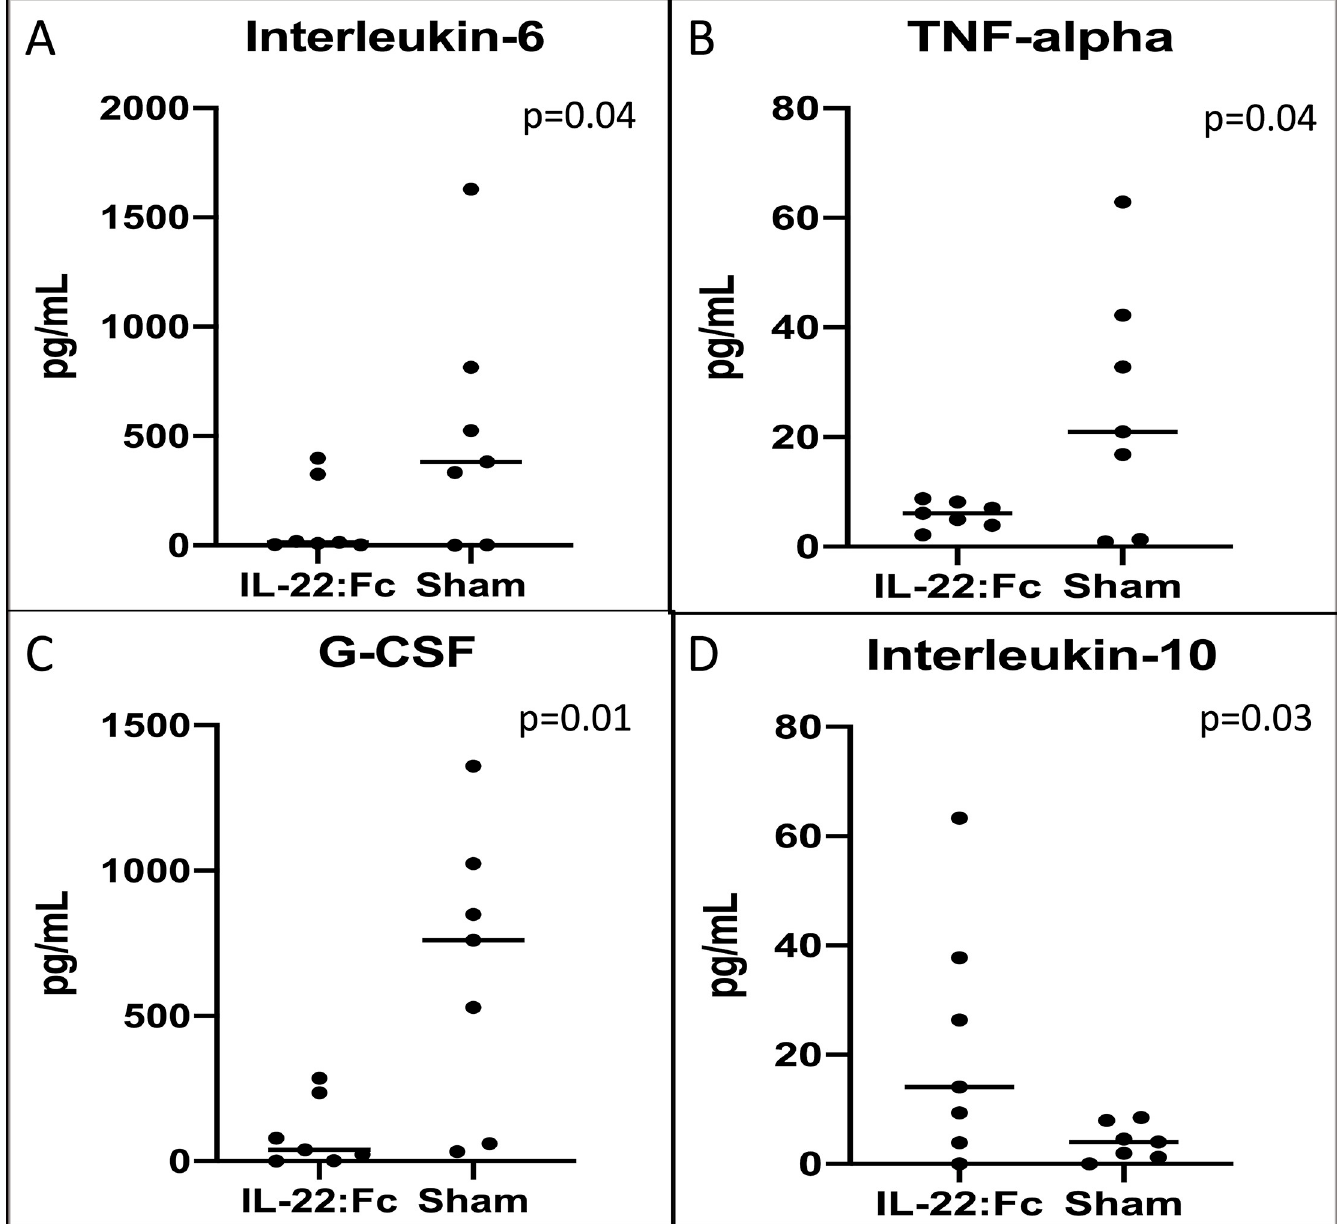
Fig 3. Measures of inflammatory mediators after high-dose LPS lung injury. Mice with high-dose LPS injury have decreased inflammation in the lungs when treated with IL-22:Fc as shown in BAL inflammatory mediators. IL-22:Fc treated mice have decreased A) Interleukin-6, B) TNF-alpha, C) G-CSF, and D) Interleukin-10.